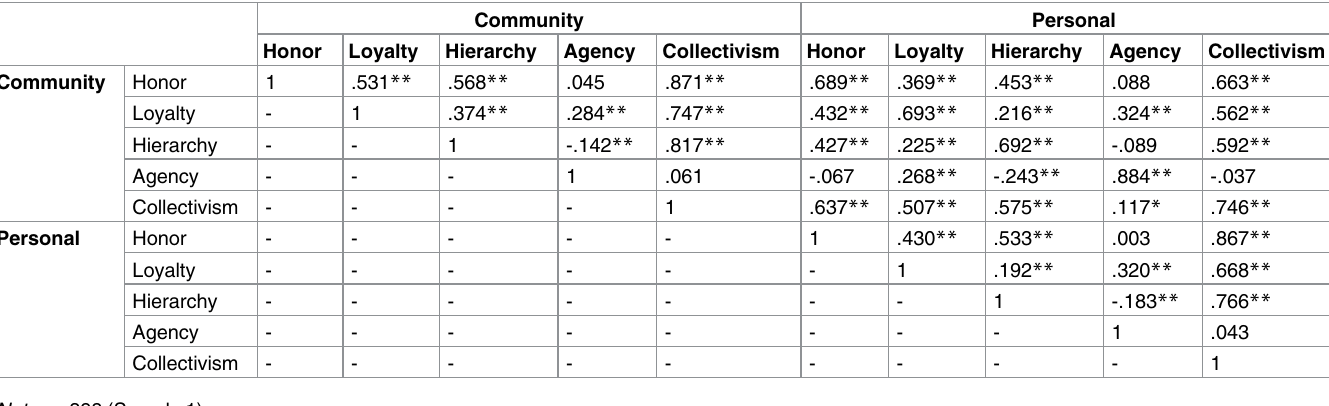
Table 3. Correlations of CCS-dimensions and